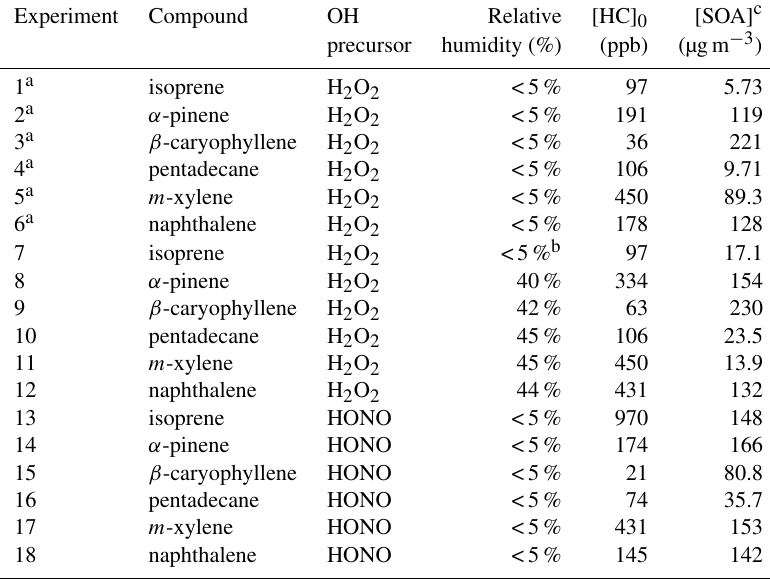
Table 1. Experimental conditions. Experiment Compound OH